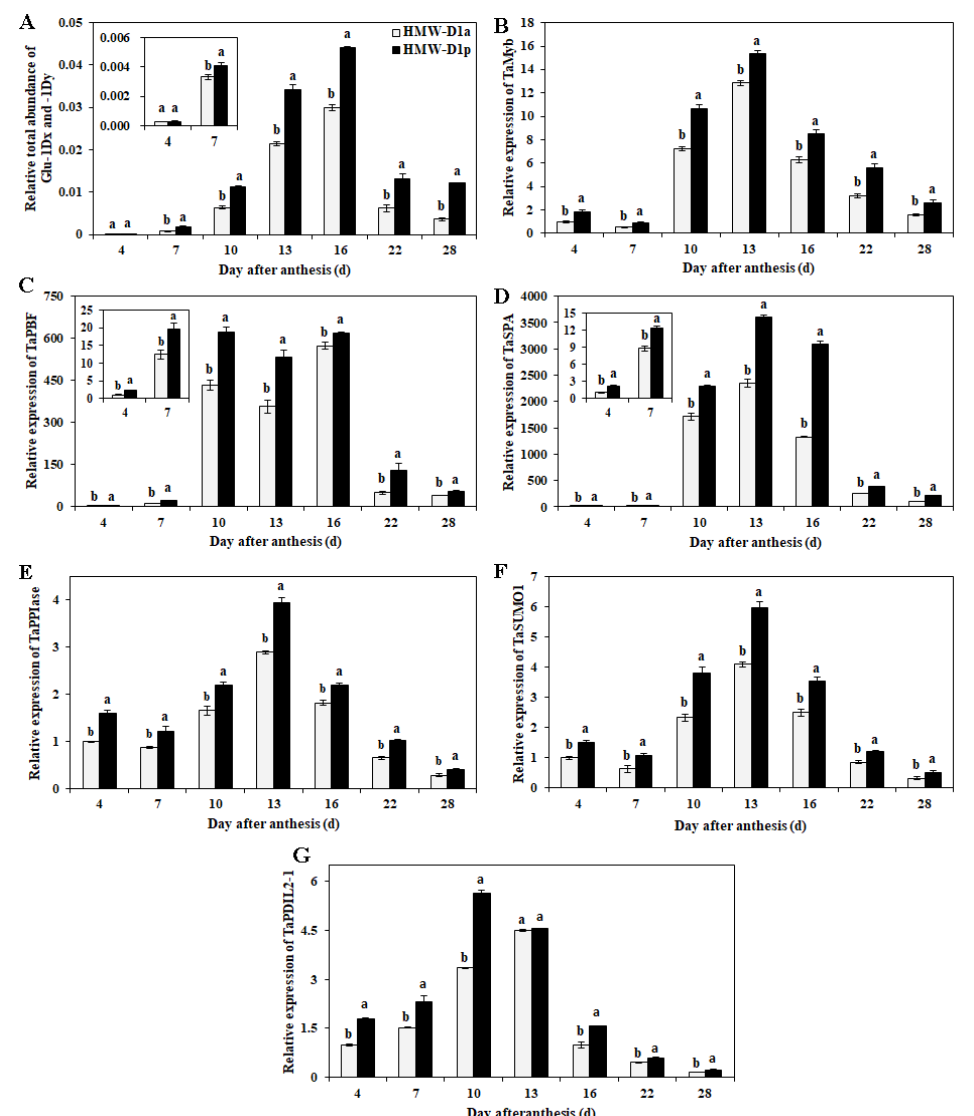
Figure 7. Expression levels of glutenin synthesis ‒ related genes in grains from HMW ‐ D1a and in 2018–2019 growing season. ( A ), Glu-1Dx + 1Dy; ( B ) TaGAMyb; ( C ) TaPBF; ( D ) TaSPA; ( E ) TaPPIase; HMW ‐ D1p in 2018 ‒ 2019 growing season. ( A ), Glu ‐ 1Dx+1Dy; ( B ) TaGAMyb; ( C ) TaPBF; ( D ) TaSPA; ( F ) TaSUMO1; ( G ) TaPDIL2-1. Gray column represents HMW-D1a and black column represents ( E ) TaPPIase; ( F ) TaSUMO1; ( G ) TaPDIL2 ‐ 1. Gray column represents HMW ‐ D1a and black column HMW-D1p. Results followed by a di ff erent letter in the same column within the same group are represents HMW ‐ D1p. Results followed by a different letter in the same column within the same significantly di ff erent ( p < group are significantly different ( p < 0.05).